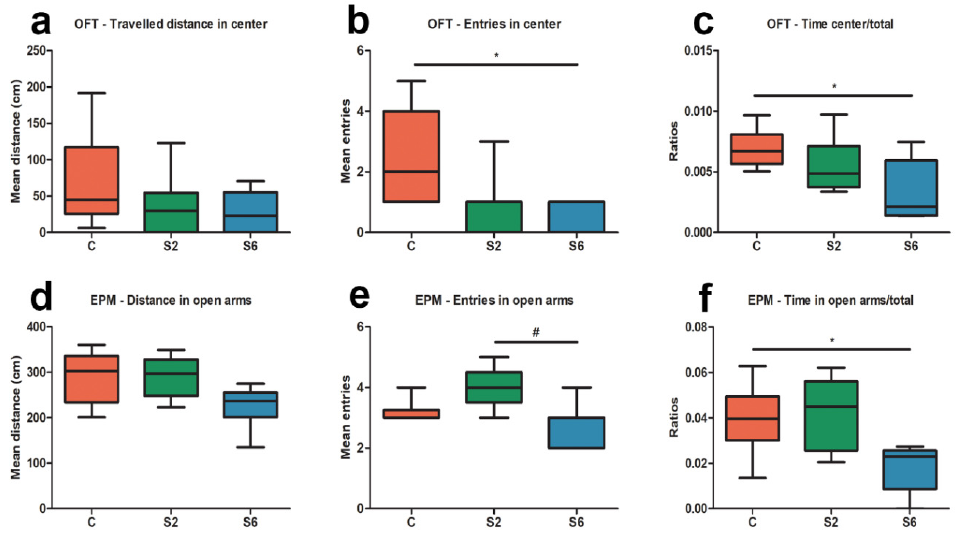
Figure 4. The effects of restraint stress on emotionality in the open field test (OFT) ( a – c ) and in the elevated plus-maze (EPM) ( d – f ). The S2, and more prominently, the S6 rats exhibited a significantly lower number of entries and spent less time in the central part of the open field arena compared to the Control group ( b , c ) ( p < 0.05). In the EPM test, the S6 rats made fewer entries in the open arms compared to S2 animals ( e ) ( p < 0.05), whereas 6 days of restraint stress significantly decreased the time spent in the open arms compared to the Control group ( f ) ( p < 0.05). Each group consisted of 7 rats. The bottom and top of the box are the first and third quartiles and the whiskers above and below the box indicate the 95th and 5th percentiles. The median is indicated as a horizontal line. The experimental groups were distributed on the X axis. The Y axis was used to expose the measuring unit for the test. The statistical significance between S2 and S6 was noted with # (# p < 0.05), whereas the comparison to Control was annotated with * (* p < 0.05). 3.3. The Stress Stimulated CNP + OCs, Ngb, and MeCP2 Was Decreased, and MeCP2 Did Not Interact with Ngb Expression Previous results mentioned that in repeated stress conditions, a type of glial cell is proliferated in the CA3 area [21]. The current data showed that CNP+ OCs were one of the gliocytes proliferated after different time of stress exposure (Figure 5a–d). Six days of stress induced a prominent OCs proliferation ( p < 0.001) compared to Control, as well as to the S2 group. In order to verify if the expressions of Ngb and MeCP2 are convergent or divergent, we labeled these markers in the Control and experimental animals. Repeated stress induced, after 2 days ( p < 0.001) and after 6 days ( p < 0.01) exposure a decrease in MeCP2 expression (Figure 5e–h) in CA3 neurons. Conversely, the same stress period induced an increased expression of Ngb ( p < 0.001) compared to the Control (Figure 5i–l). Additionally, compared to 2 days of stress exposure, 6 days of repeated stress increased Ngb expression ( p < 0.001) in CA3 hippocampal area. However, the literature is relatively incomplete when it comes to Ngb regulation. Due to limited antibody availability, we investigated if there was any in silico link between the MeCP2 (Methyl-CpG-binding protein 2) (encoded by MeCP2) and the expression of Ngb gene, encoding neuroglobin. Using the STRING platform v.11.0 [53] we firstly thought to identify any basic interactions between the two proteins mentioned afore. The network had a total of 11 nodes and 36 edges, none of which revealed any relevant interaction with the expression of Ngb. Thus, at a first glance, only some indirect or distant pathways might be considered as viable connections between these two entities, since no direct interactions based on the amino acids sequence of MeCP2 were detected (Figure 6a). Searching in various databases (such as GTRD, TRRUST v 2.0-both human and mice, Harmonizome, TRANSFAC 7.0 Public